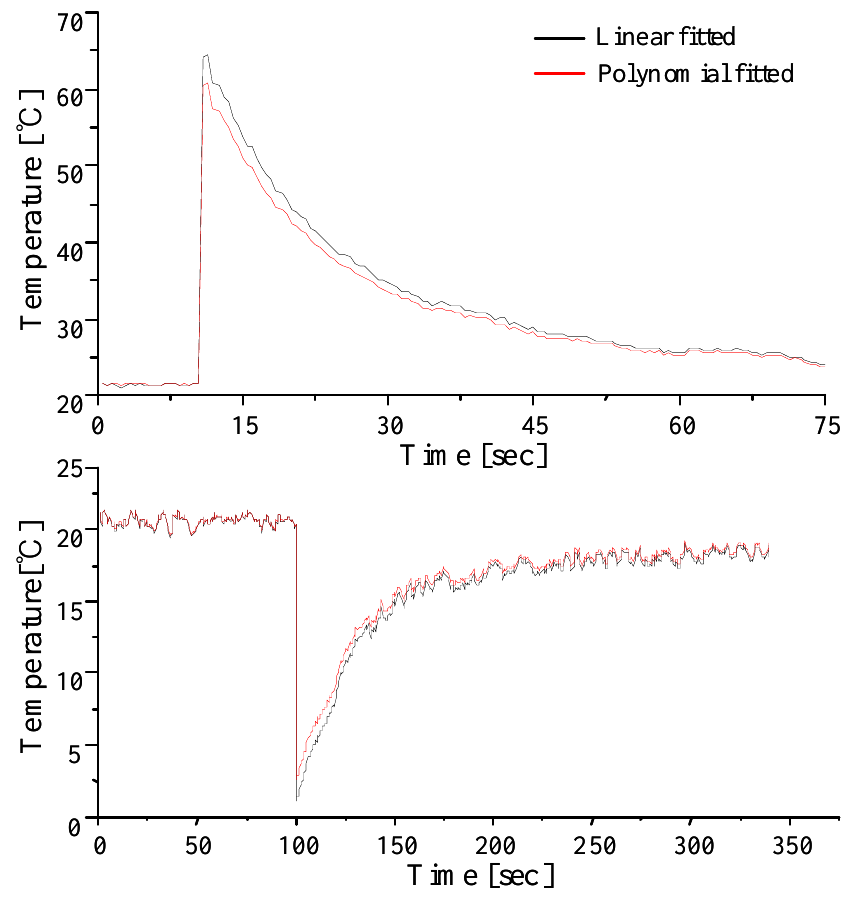
Figure5. Temperature measurements with linear and polynomial fitting methods.